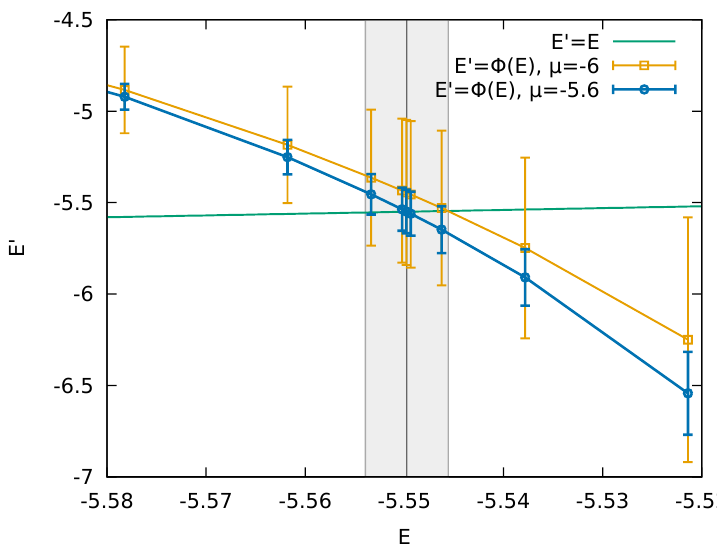
Figure 16: Energy estimation using the self-energy in imaginary time with φ ( E ) , the right hand side of Eq. 17. Same parameters are used as before ( α = 5; µ = − 6 and µ = − 5.6, respectively). The intersection point with the E (cid:48) = E line determines the polaron ground state energy. It is marked for the case of µ = − 5.6 and its error bars are given by the gray